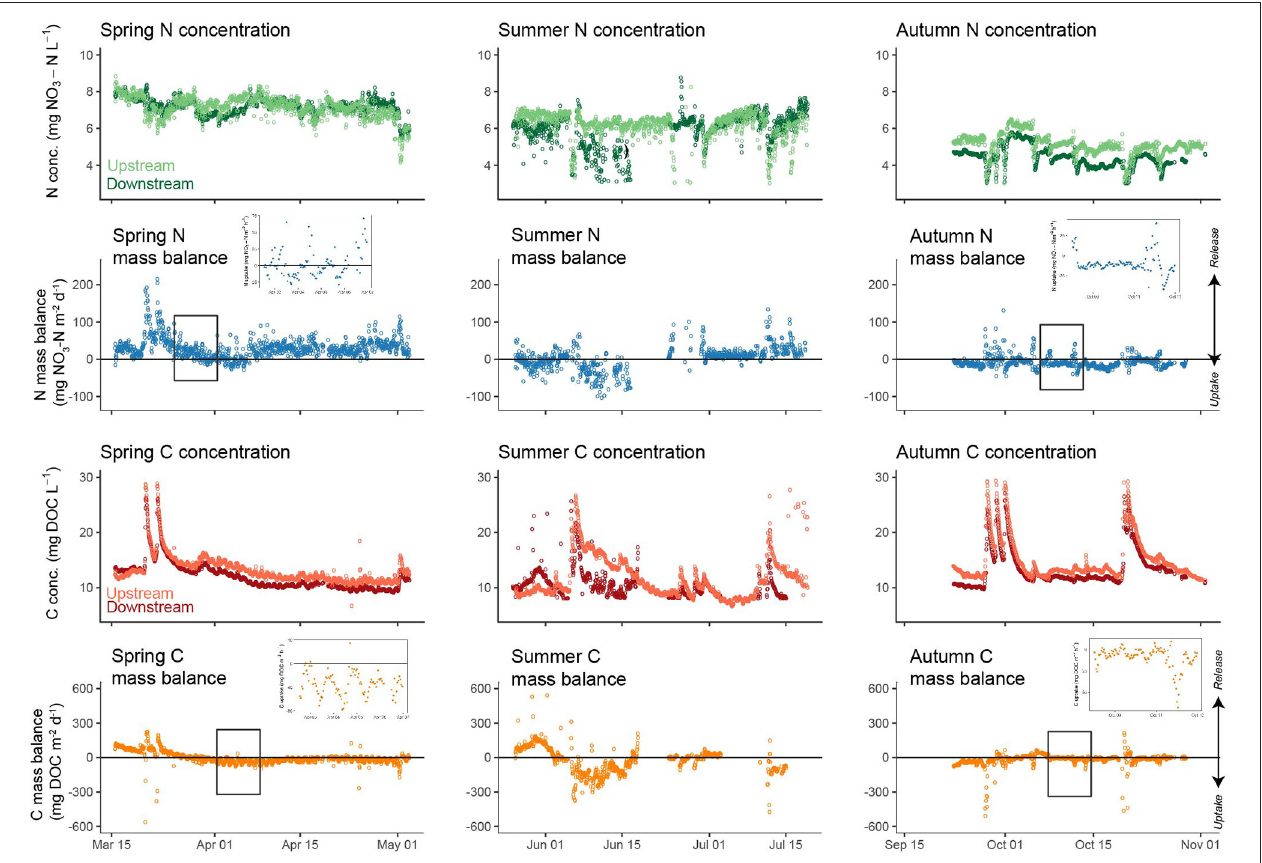
FIGURE 4 | Hourly NO − 3 -N and DOC concentration and mass balance dynamics in spring, summer, and autumn. Inset graphs provide detailed views of diel dynamics. Values of nutrient mass balance < 0 indicate net removal from the water column.